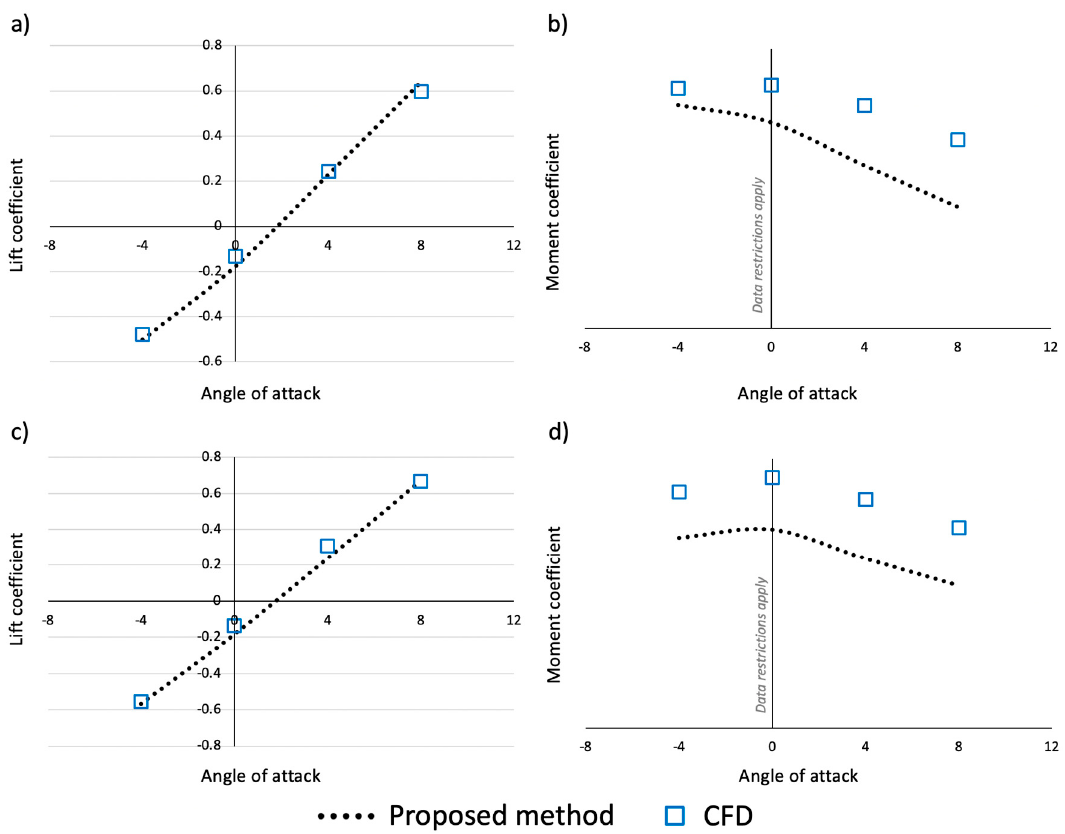
Figure 15. Lift and moment coefficient prediction for takeoff conditions, with- ( c , d ) and without ( a , b ) ground effect corrections.